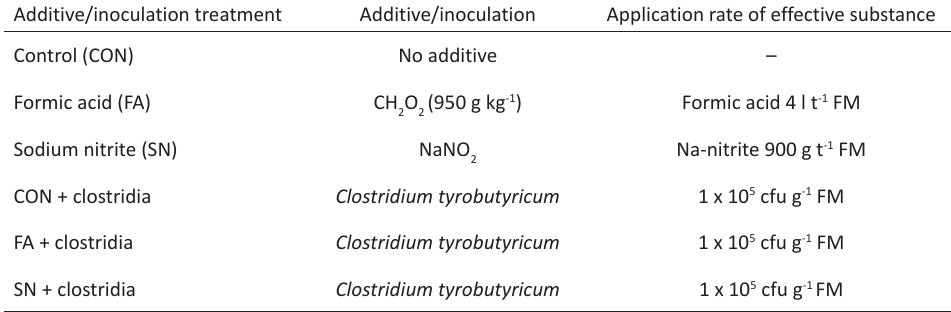
Table 1. Additive treatments and clostridial spore inoculation of red clover-based silages Additive/inoculation treatment